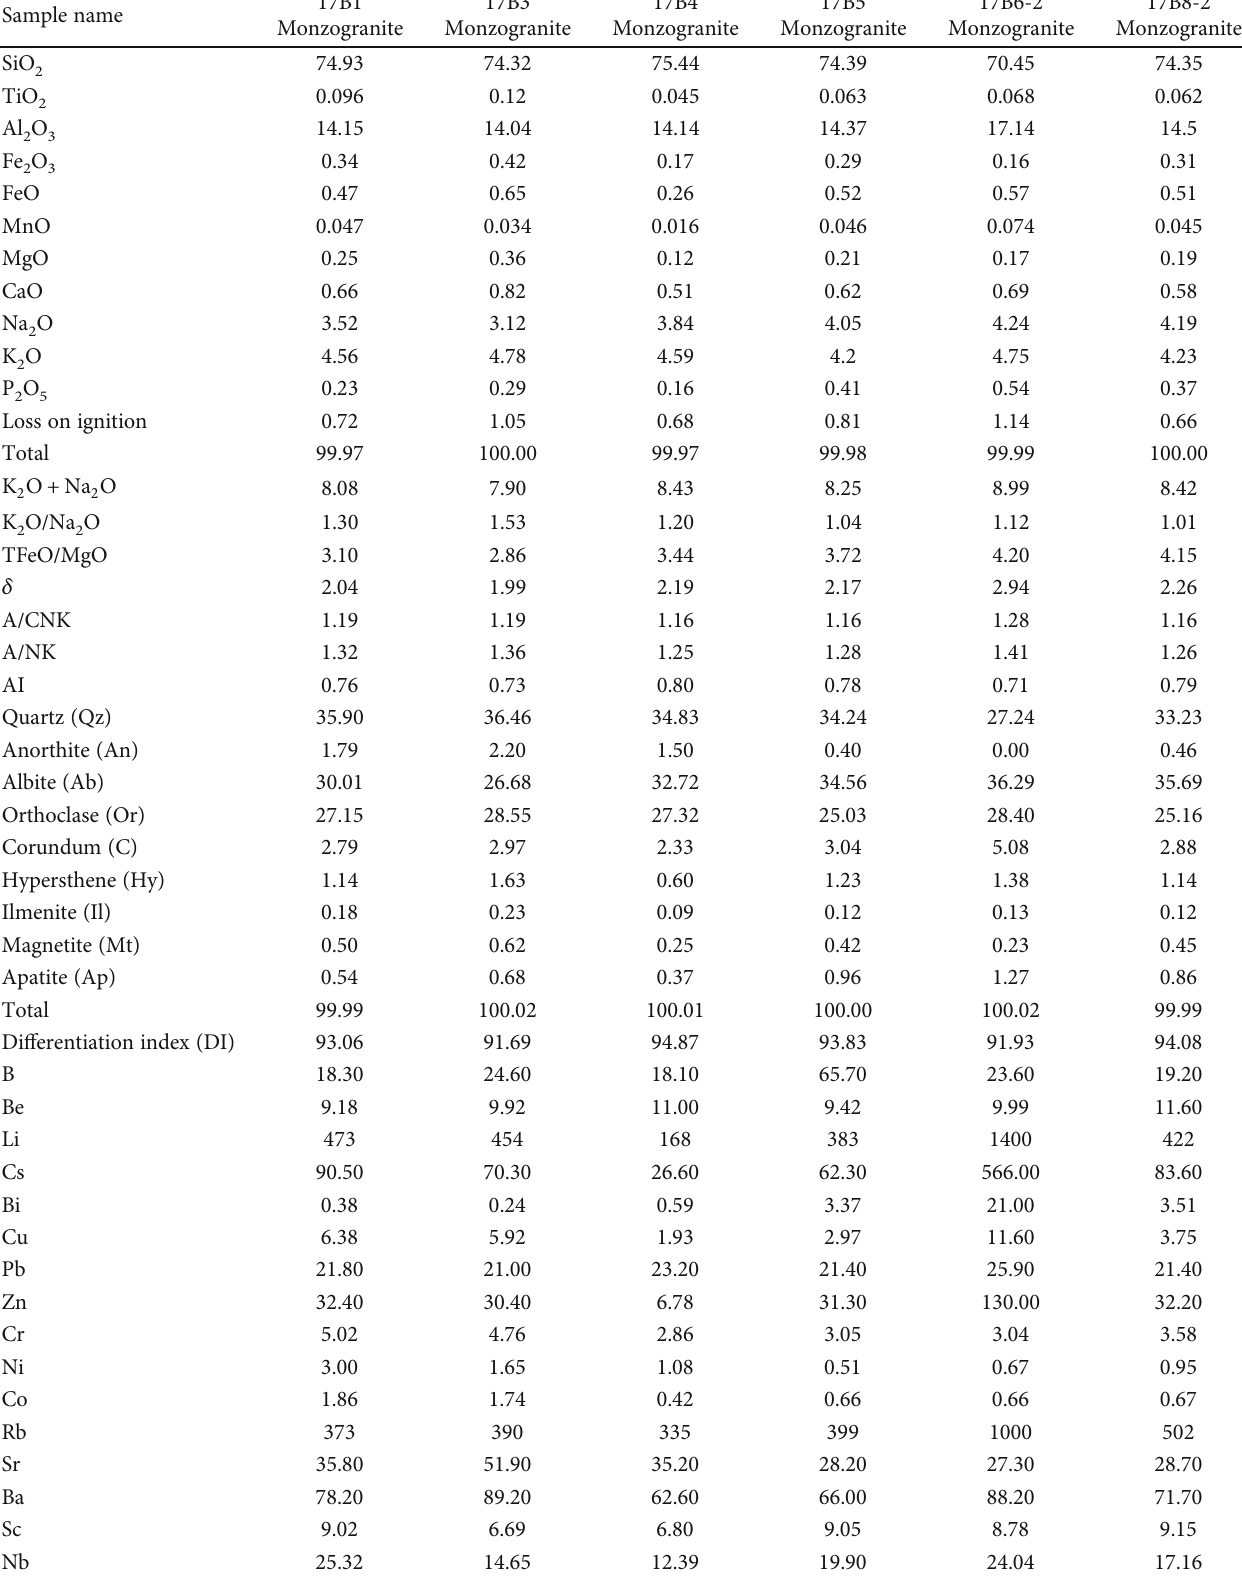
Table 3: Compositions of major element (%), trace element ( × 10 -6 ), and REE ( × 10 -6 ) of the Bieyesamas